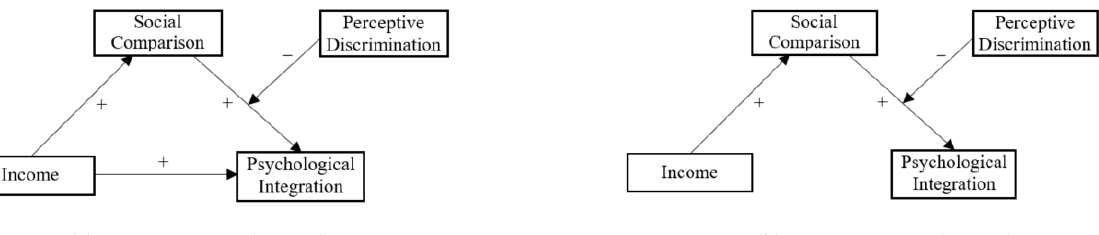
Figure 3. Psychological integration paths of migrant workers in different groups.